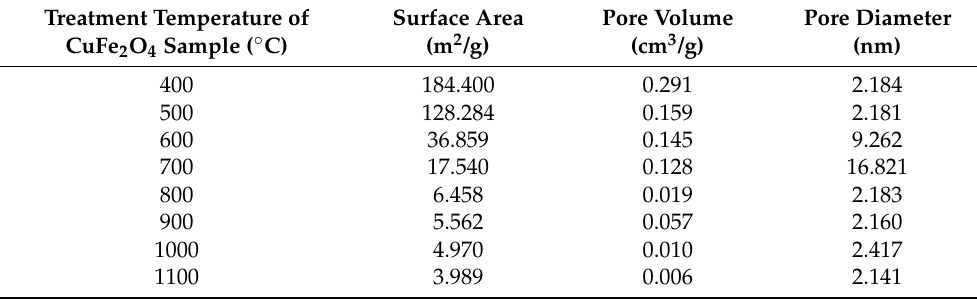
Figure 7. The adsorption–desorption isotherm (insertion—BJH pore size distribution) of the CuFe 2 O 4 samples calcined to: ( A ) 400 °C and ( B ) 1100 °C. Table 1. The adsorption–desorption data of the CuFe 2 O 4. samples.